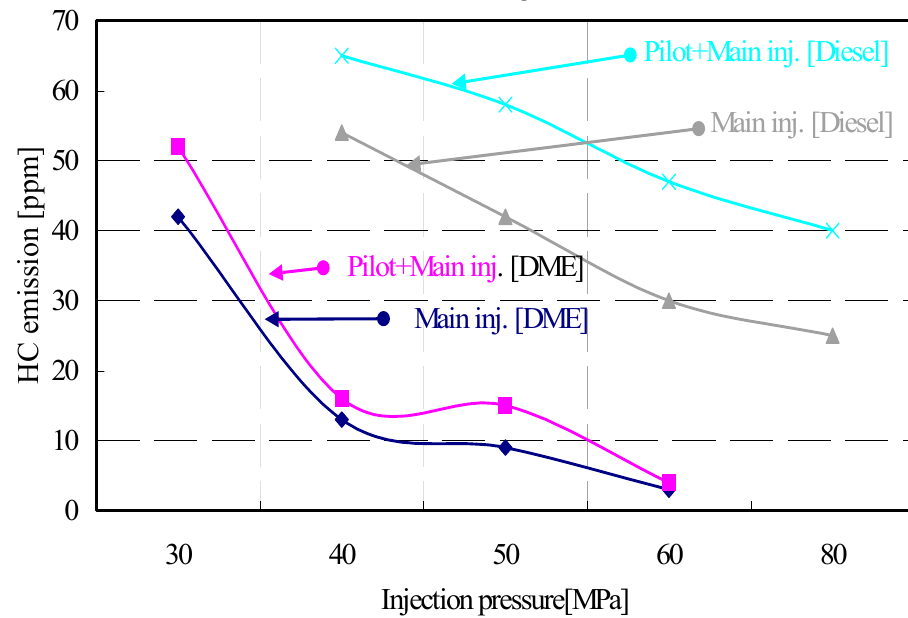
Figure 9. HC emission characteristics of diesel and DME engines with and without pilot injection as a function of injection pressure.